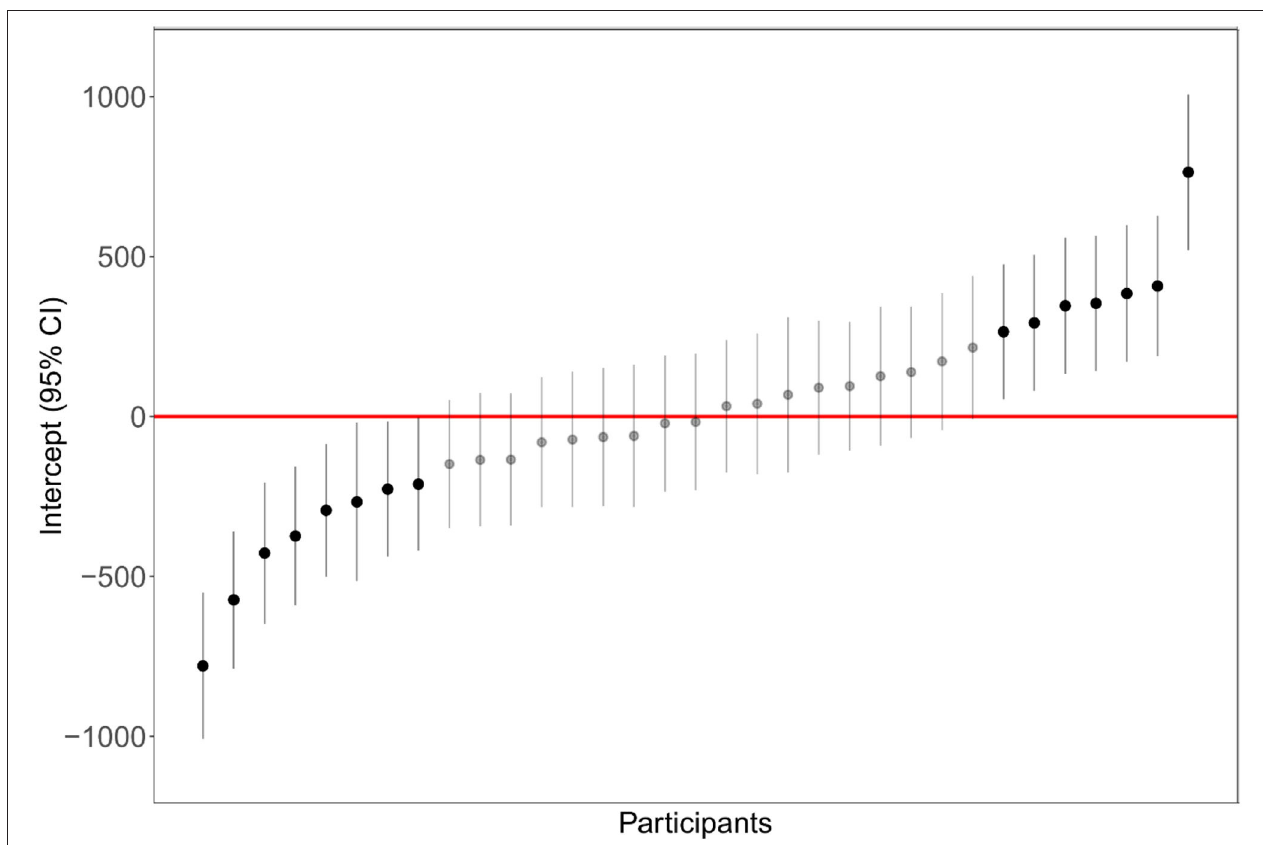
FIGURE 7 | Distribution of participants’ intercept (random effect) in the linear mixed model testing cumulative fixation time as a function of aggregation level and aggregation type.